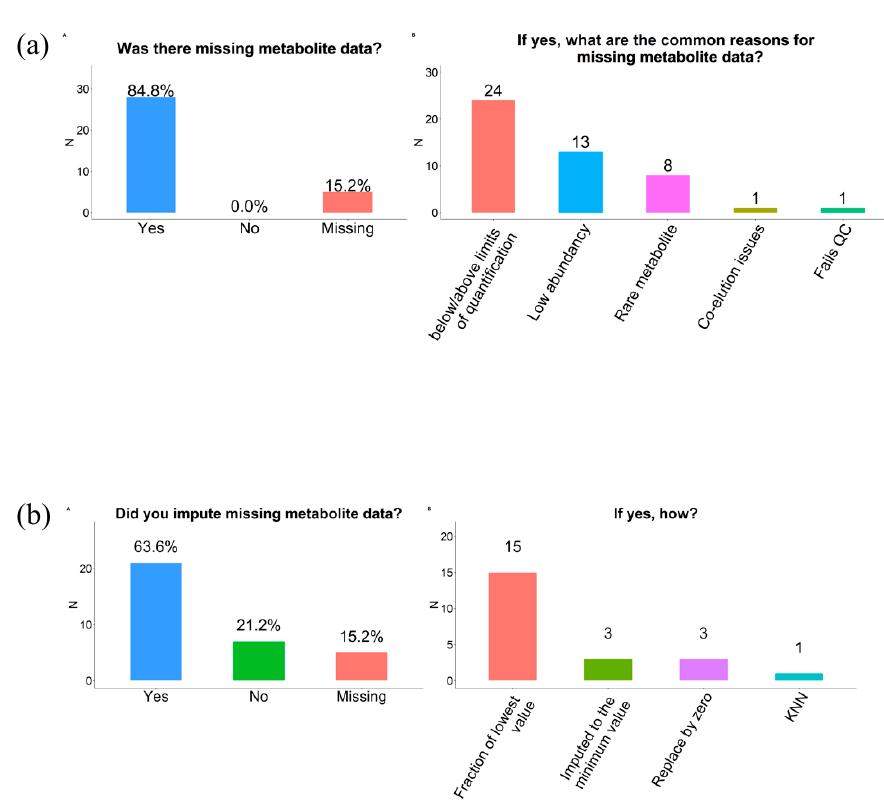
Figure 3. Data pre-processing steps conducted among participating COMETS cohorts. ( a ) Missingness; ( b ) Imputation of missing values.